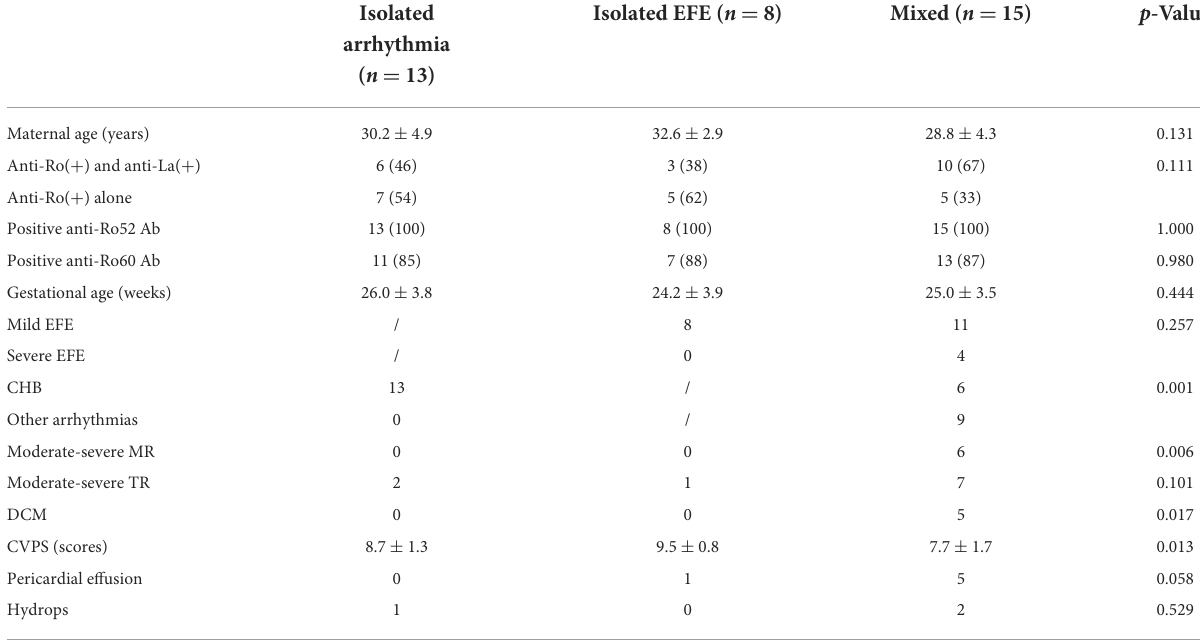
TABLE 1 Clinical and echocardiographic data of fetuses with three cardiac manifestations due to maternal anti-Ro and anti-La antibodies. Isolated Isolated EFE ( n = 8) Mixed ( n = 15) p -Value arrhythmia ( n = 13)